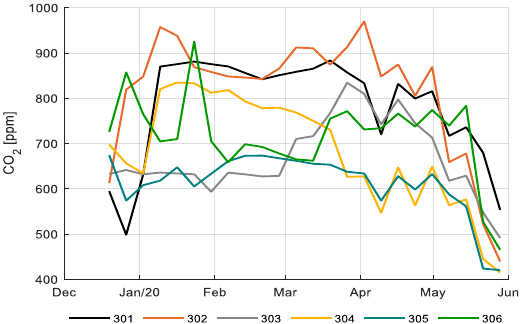
Figure 7. Weekly average CO 2 concentration (ppm) during the light period in different greenhouse compartments (301–306). Figure 8. Daily CO 2 dosage (g/m 2 ) in different greenhouse compartments (301–306). Data smoothed by a moving average filter of 3 days.